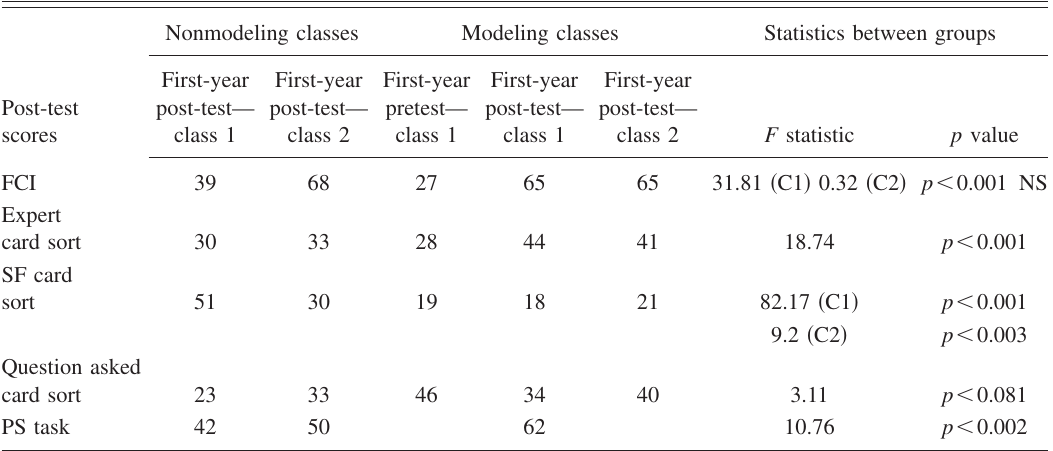
TABLE I. Study 1: test scores for modeling and nonmodeling groups